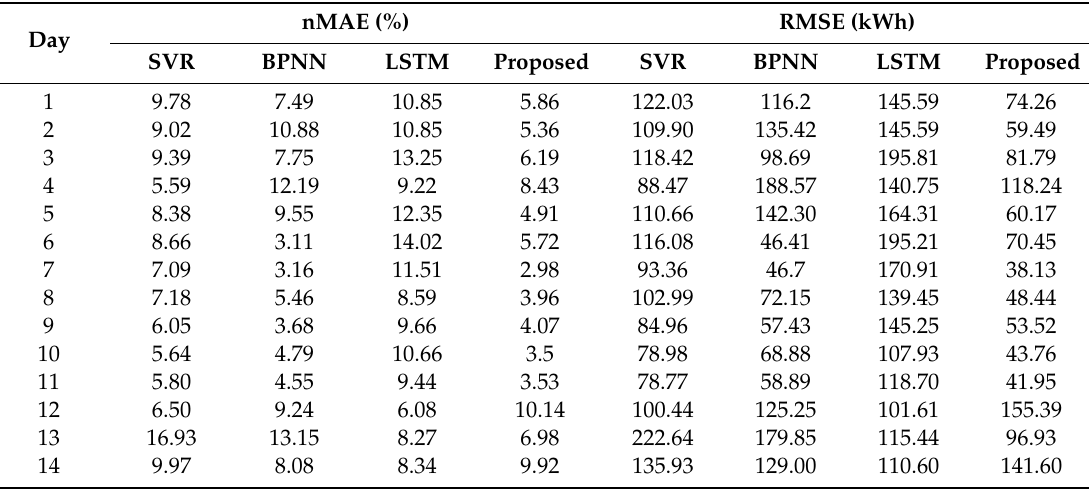
Table 4. Normalized mean absolute error (nMAE) and root-mean-square error (RMSE) of PV power forecasting with and without the proposed similar day detection